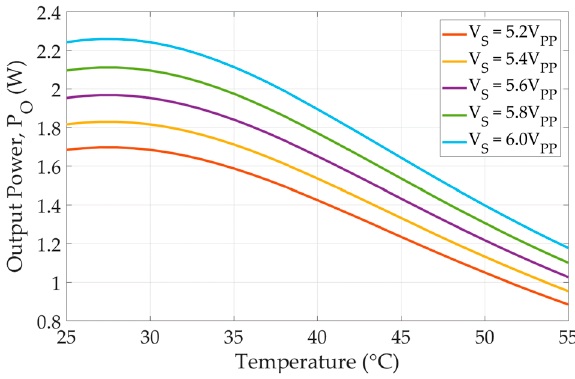
Figure 5. The variation in the output power per the driving voltage increases in different tempera- tures.